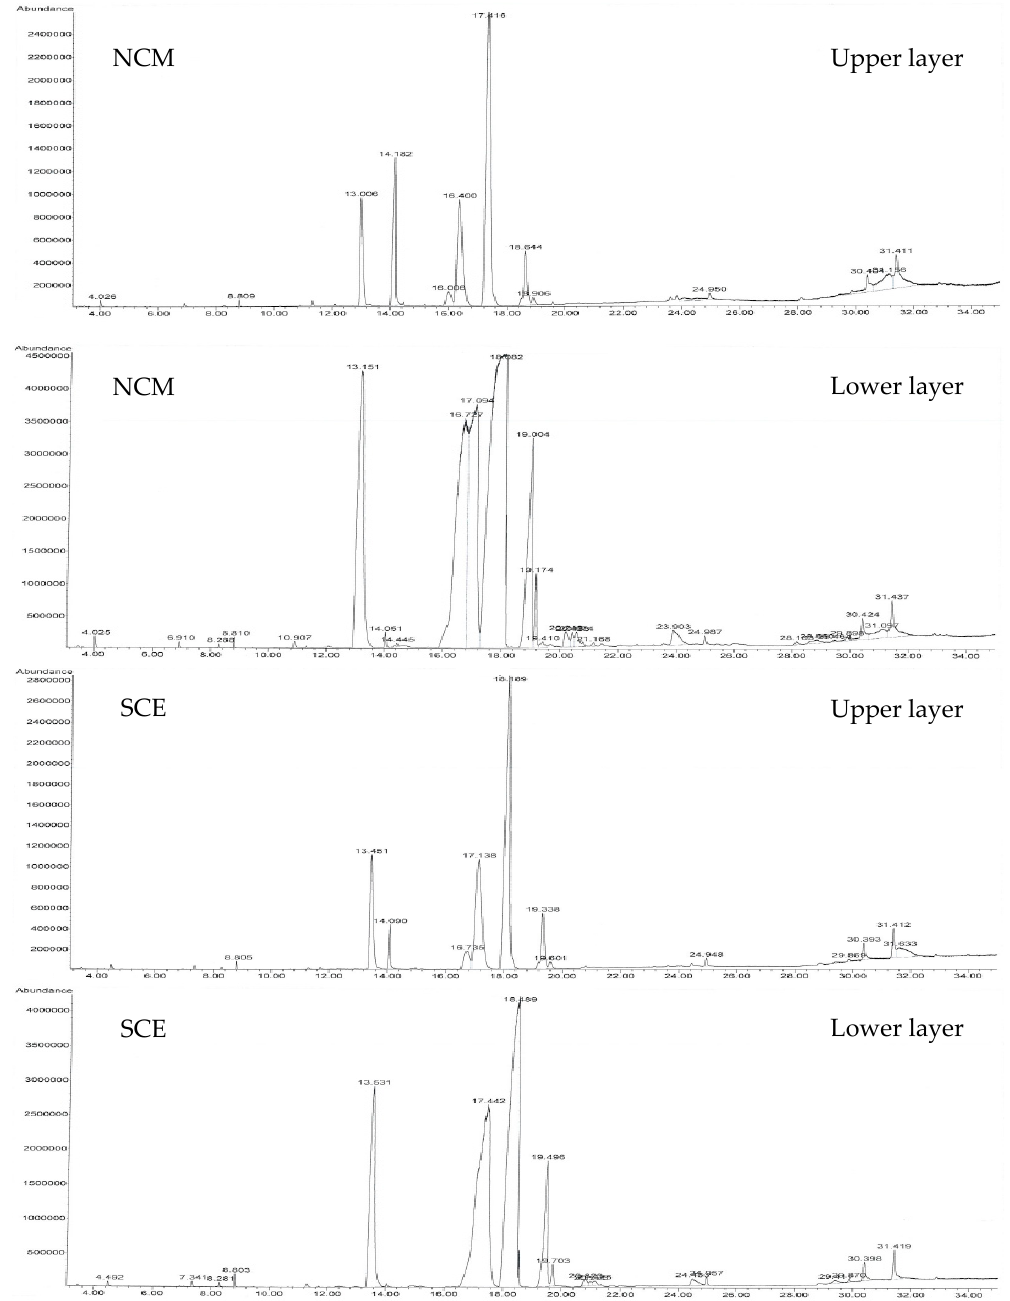
Figure 6. GC chromatogram of products from VCO by the supercritical method.